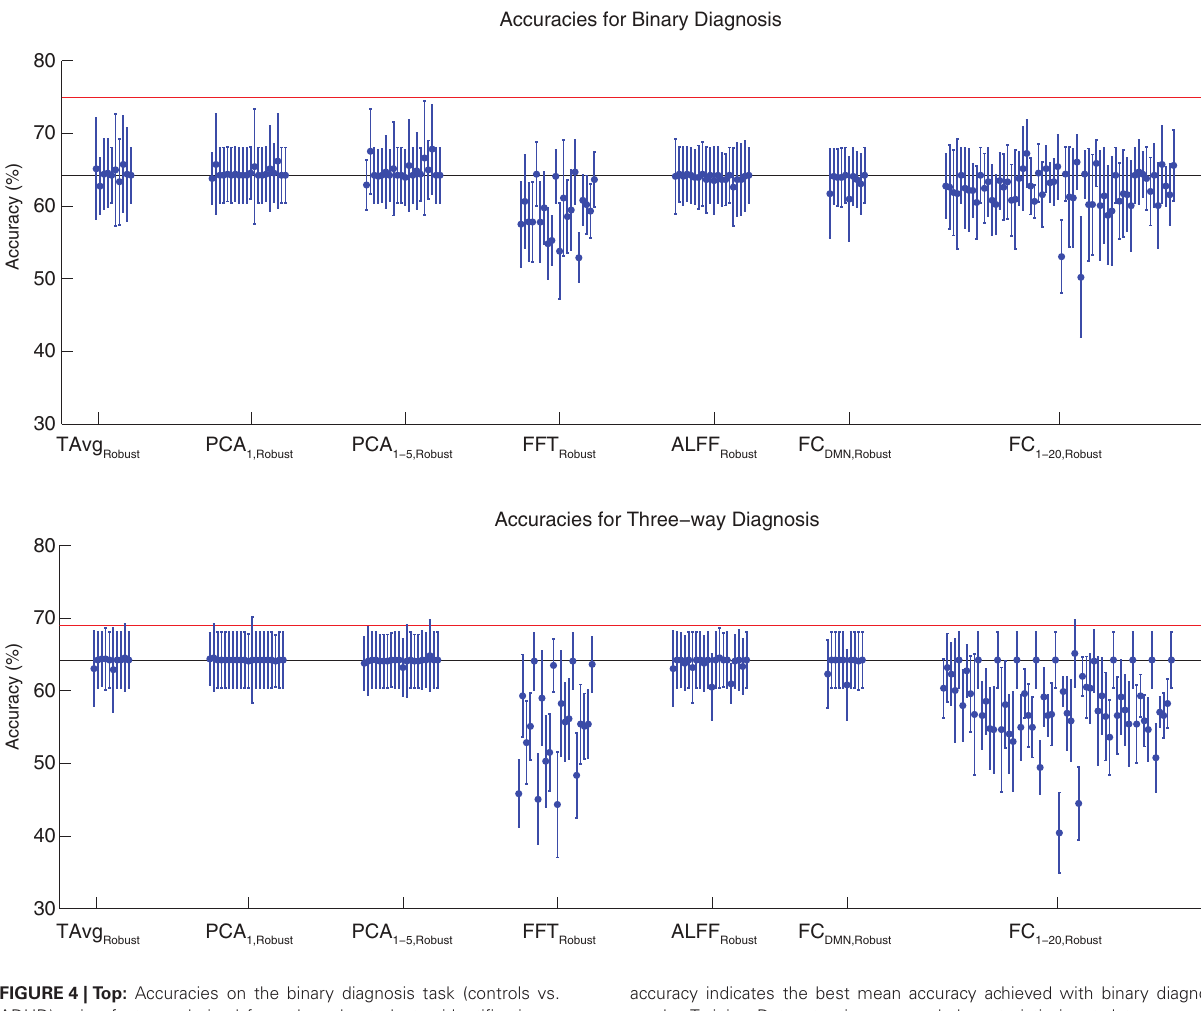
accuracy indicates the best mean accuracy achieved with binary diagnosis on the Training Dataset using personal characteristic input data (section 3.1). Bottom : Accuracies on the three-way diagnosis task (controls vs. ADHD-C vs. ADHD-I) using the same Diagnostic Pipelines as in top panel . The red horizontal line at 69.0% accuracy indicates the best mean accuracy achieved with three-way diagnosis on the Training Dataset using personal characteristic input data (section 3.1). Other conventions as in top panel